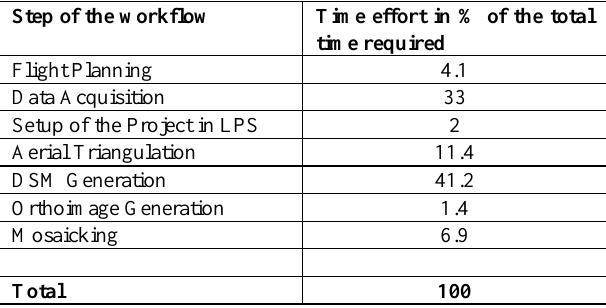
Table 1: Distribution of time effort for the different steps of UAV photogrammetry (estimation based on a test using 10 images and 10 GCPs).